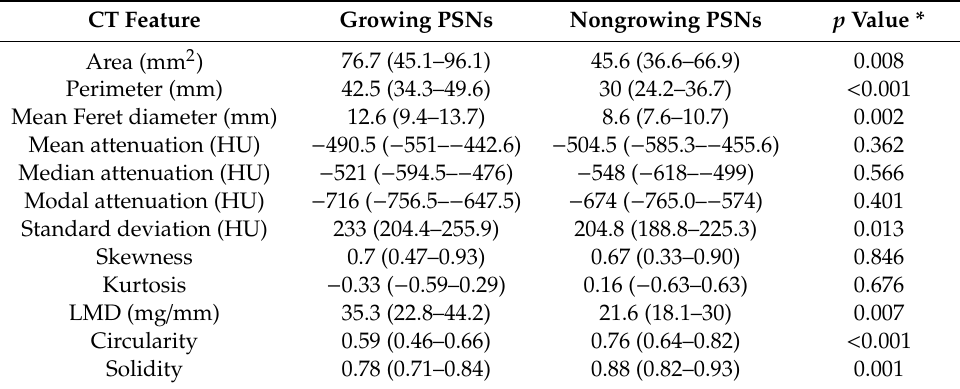
Figure 4. Growth pattern of the 33 growing part-solid nodules (PSNs) based on the linear mass density (LMD) changes during the follow-up CT scan. Table 3. Quantitative CT features calculated from the baseline CT images of growing and nongrowing part-solid nodules (PSNs).